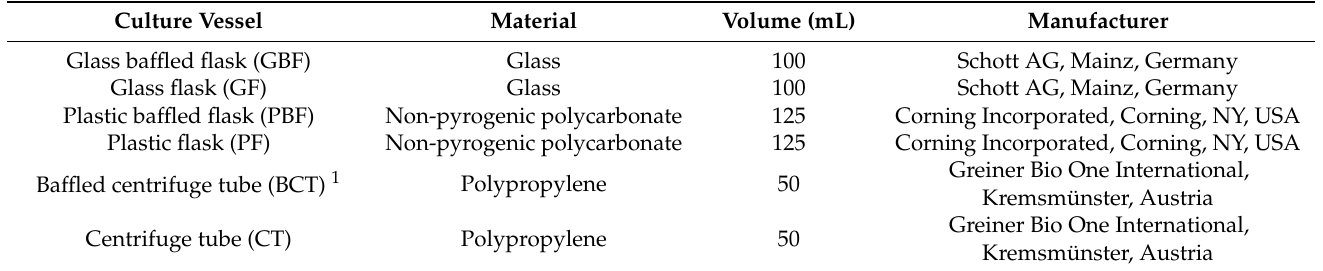
Table 1. Different culture vessels utilized for analysis of the impact of in vitro assay conditions on